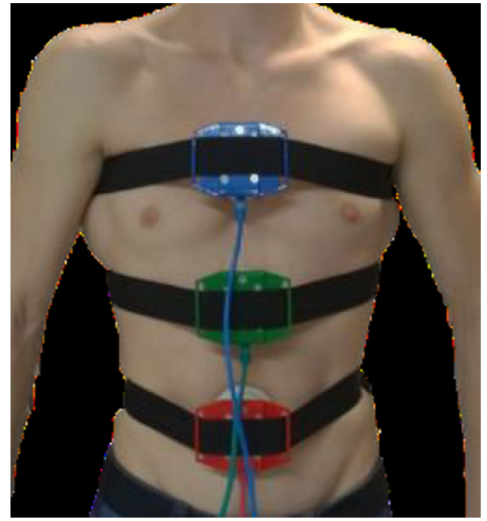
Figure 1. The positions of the location of probes on the body.